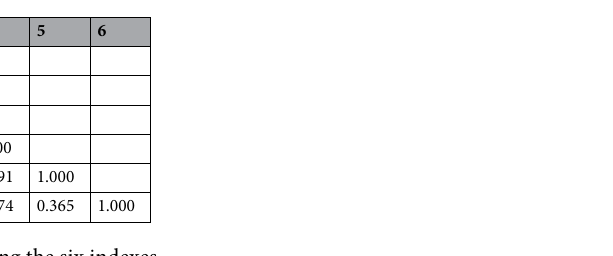
Table 4. Correlation coefficients among the six